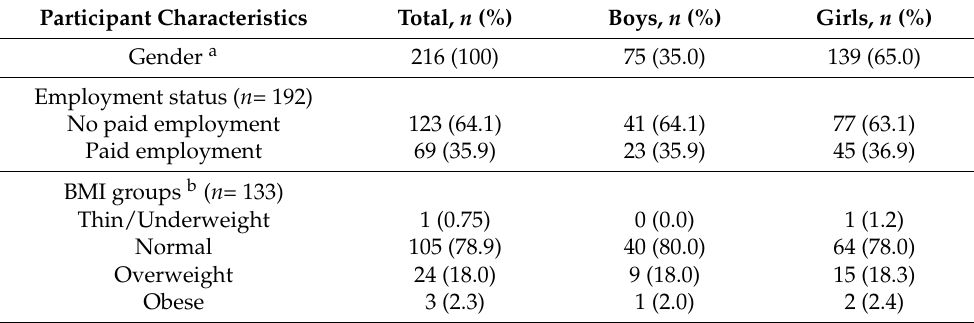
Table 1. Participant characteristics by